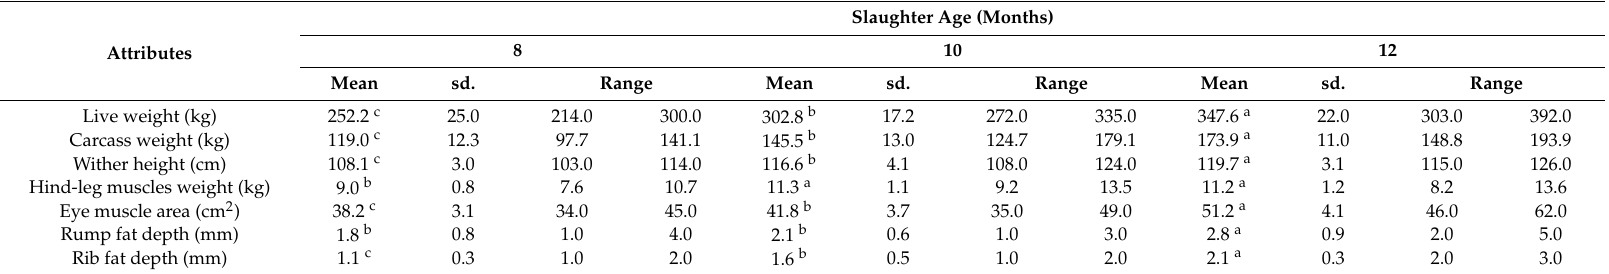
a,b,c Superscript within row trait indicates means are significantly di ff erent at p < 0.05; sd.: standard